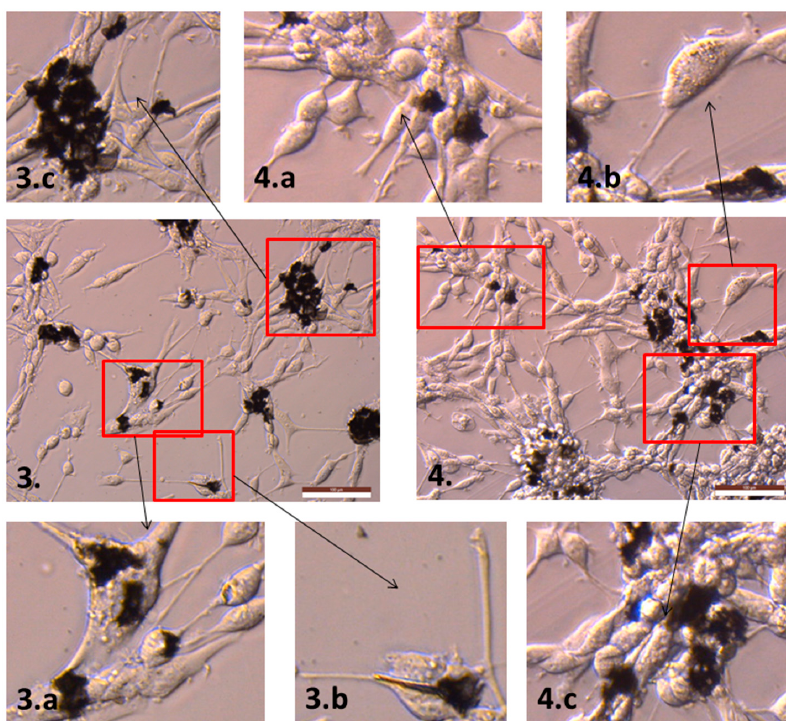
Figure A2. Morphology of U87 cells treated with rGO flakes, as evaluated by optical microscopy. Cells treated with graphene flakes (at concentration of 50 µ g/mL)—(3–4) rGO/ATS. Regions of interest marked with red borders, are shown enlarged, and are indicated by black arrows. Scale bar: 100 µ